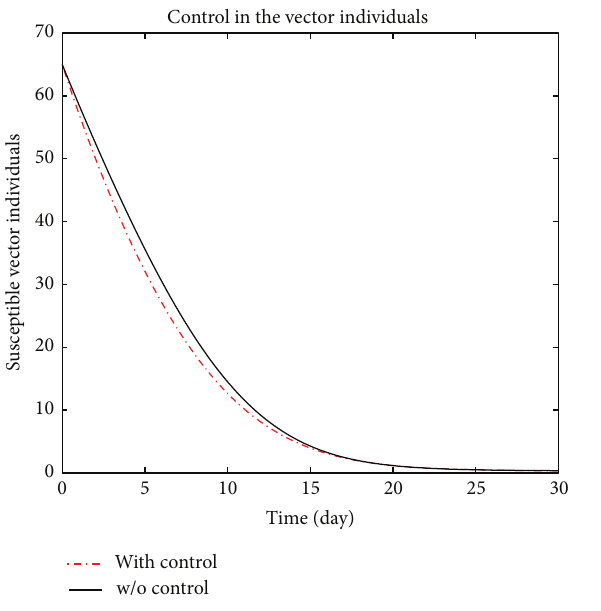
Figure 4: Plot of the number of infected vectors with and without control, 𝑢 1 ̸=0 , 𝑢 2 ̸=0 .